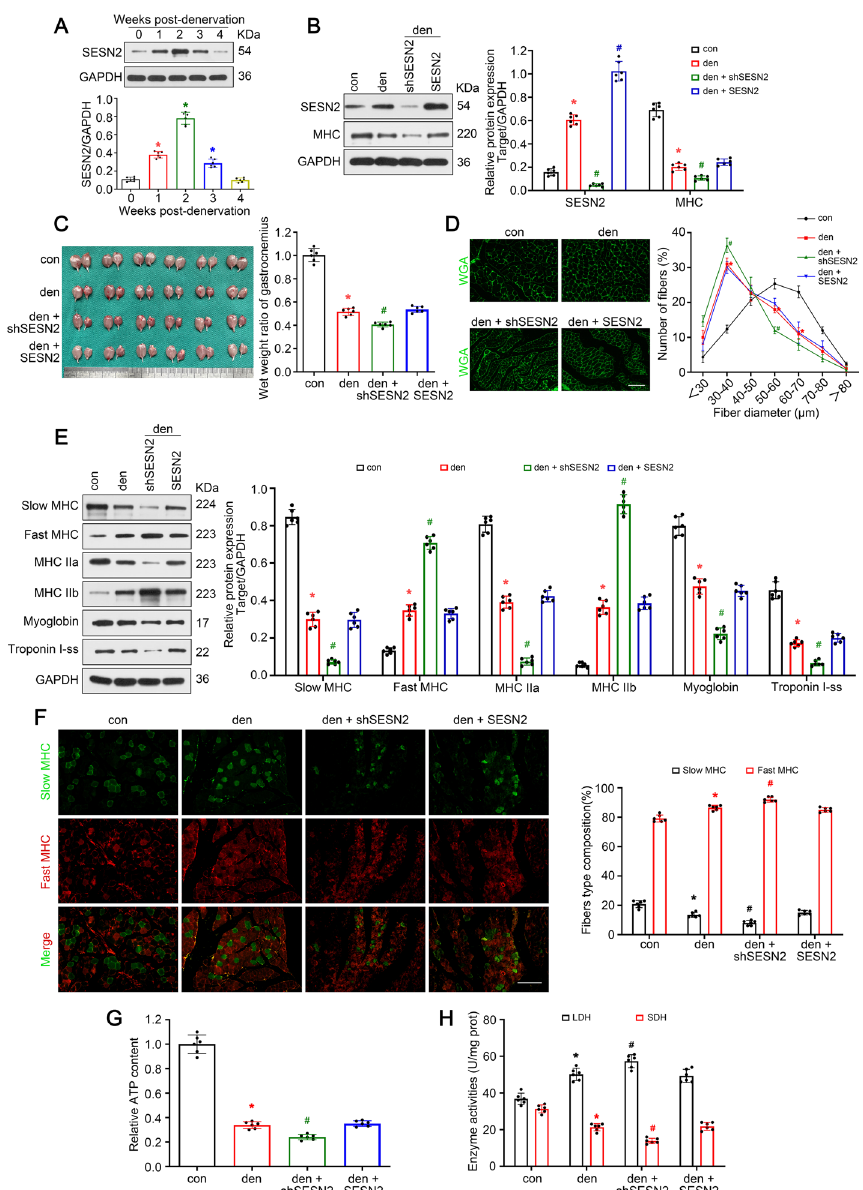
Fig. 2 SESN2 protected against muscle atrophy and myofiber type transition after denervation. A Western blot analysis of SESN2 expression in GAS post-denervation. B Western blot analysis confirming the expression of SESN2 and MHC . C Appearance and wet weight ratio of GAS in different groups. D Quantification of muscle fiber diameter by immunofluorescence staining of WGA. Scale bar, 50 μm. E Western blot analysis of proteins related to muscle fiber type. F Immunofluorescence analysis of fiber type composition in denervated GAS. Scale bar, 50 μm. G , H Relative ATP content and metabolic enzyme activities (LDH and SDH) in GAS. Data presented as mean SD. n 6. * P < 0.05 versus control (week 0 or sham operation group). # P < 0.05 versus ± = denervation group. Den denervation, Con